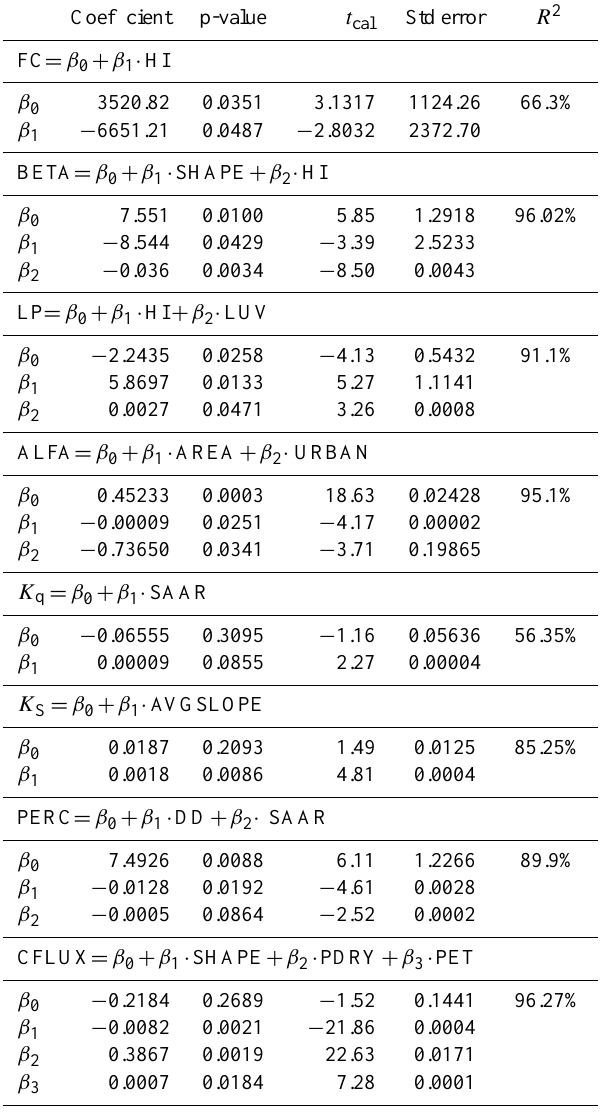
Table 5. The regional model and its statistical